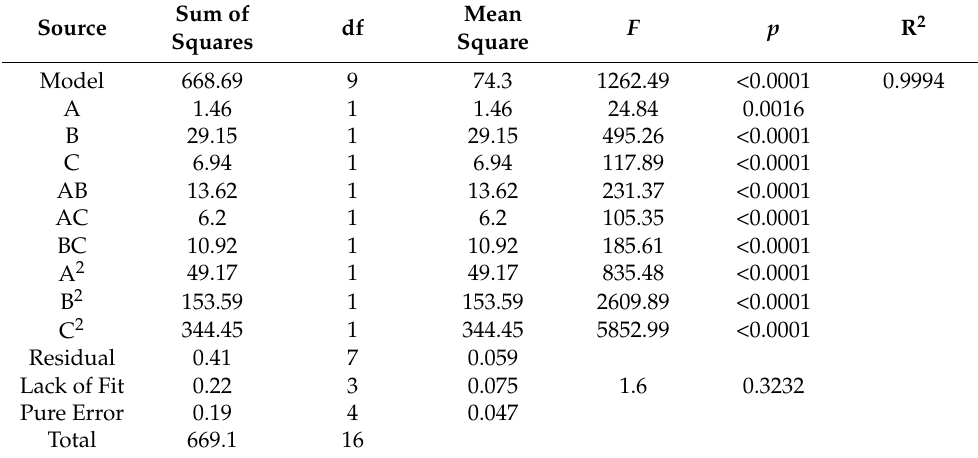
Table 4. Variance analysis of SS regression